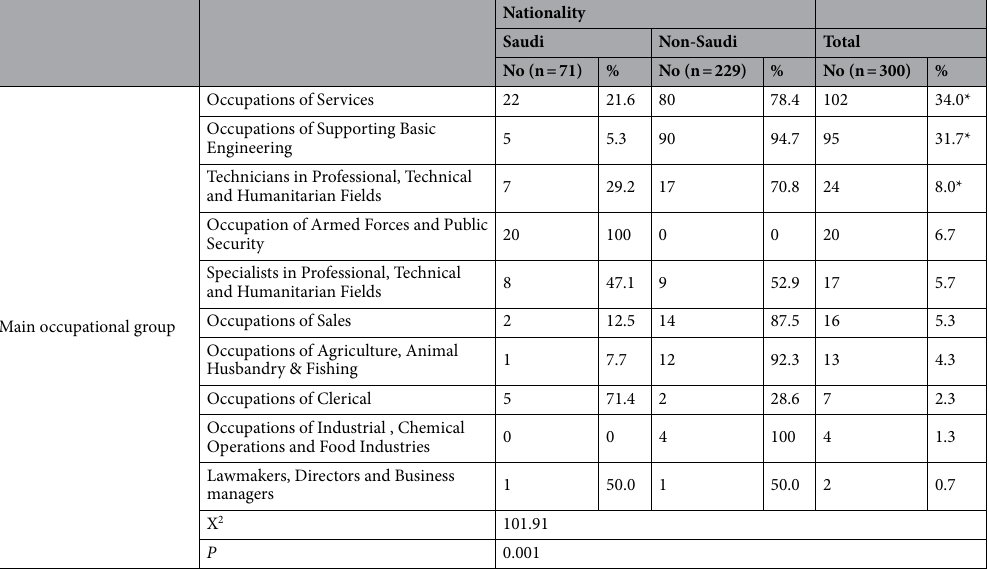
Table 3. Comparing the Nationality among main occupational group of TB cases among workers in Makkah region